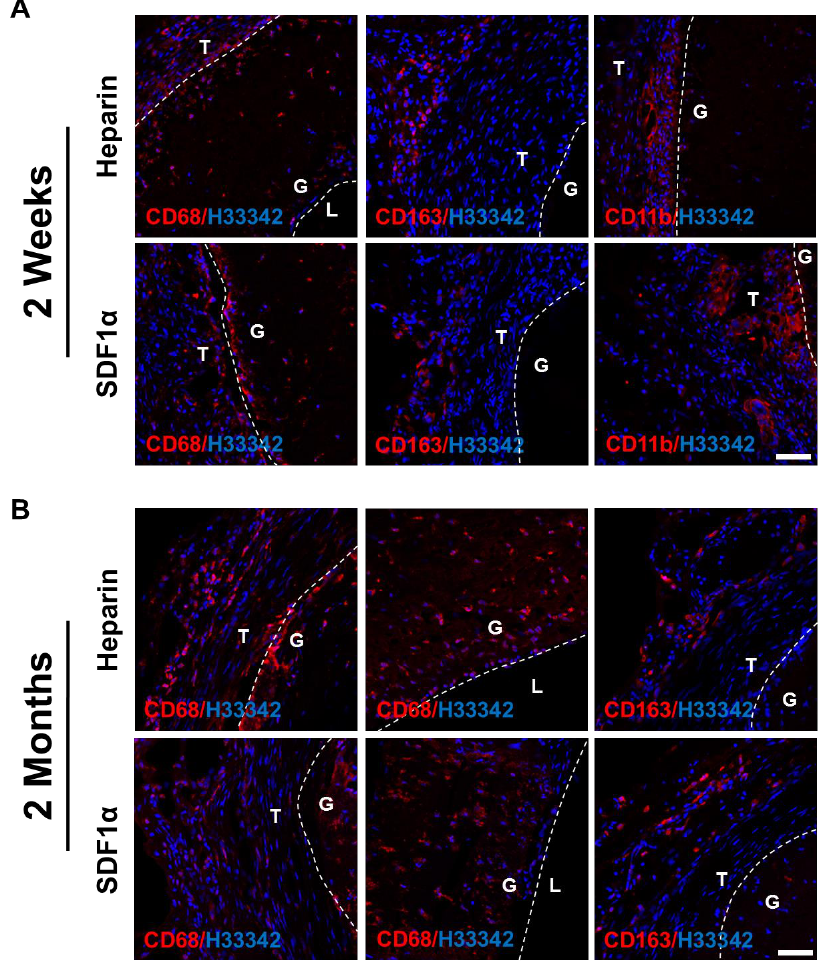
Figure 9. Inflammatory responses of vascular grafts. Immunostaining for CD68 ( red ), CD163 ( red ) and CD11b ( red ) of heparinized and SDF-1α immobilized grafts at ( A ) 2 weeks and ( B ) 2 months after implantation. Nuclei were stained with Hoechst 33342 ( blue ). Dashed lines are used to distinguish the boundaries between L (lumen), G (graft), and T (surrounding tissues). Scale bar = 50 μm.